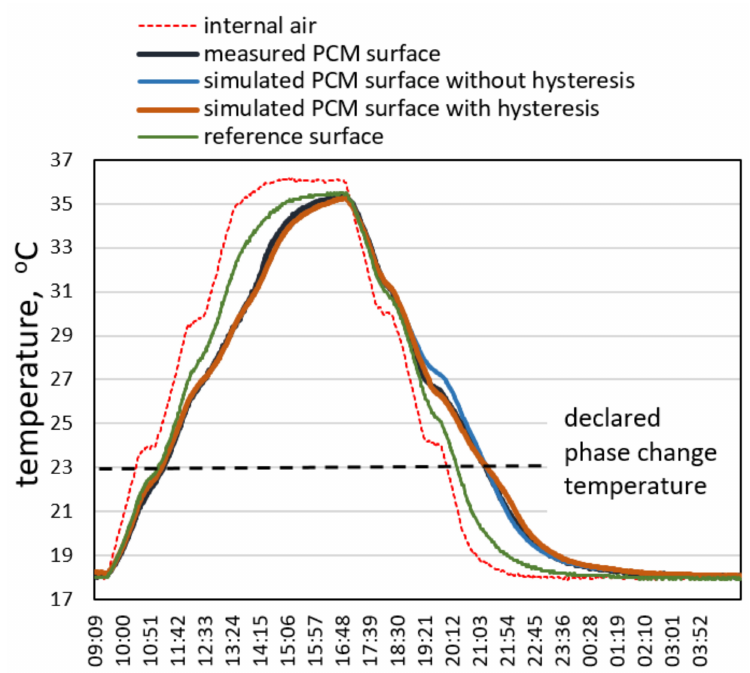
Figure 4. Measured versus simulated temperature fluctuations of the phase change materials’ (PCM)